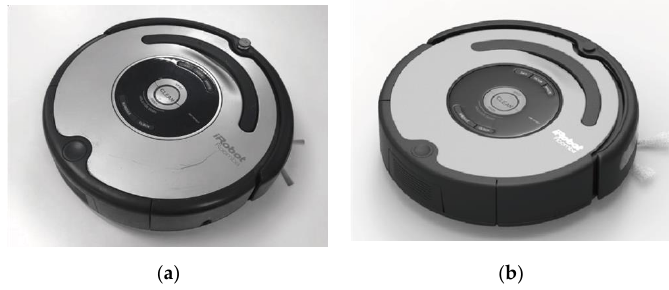
Figure 6. ( a ) Physical product vs. ( b ) virtual prototype.